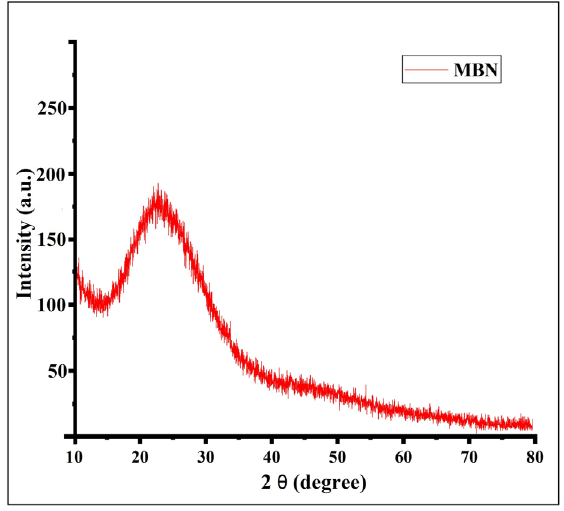
Figure 3. FT-IR spectrum presenting the functional group for the nanoparticles loaded with the tideglusib.